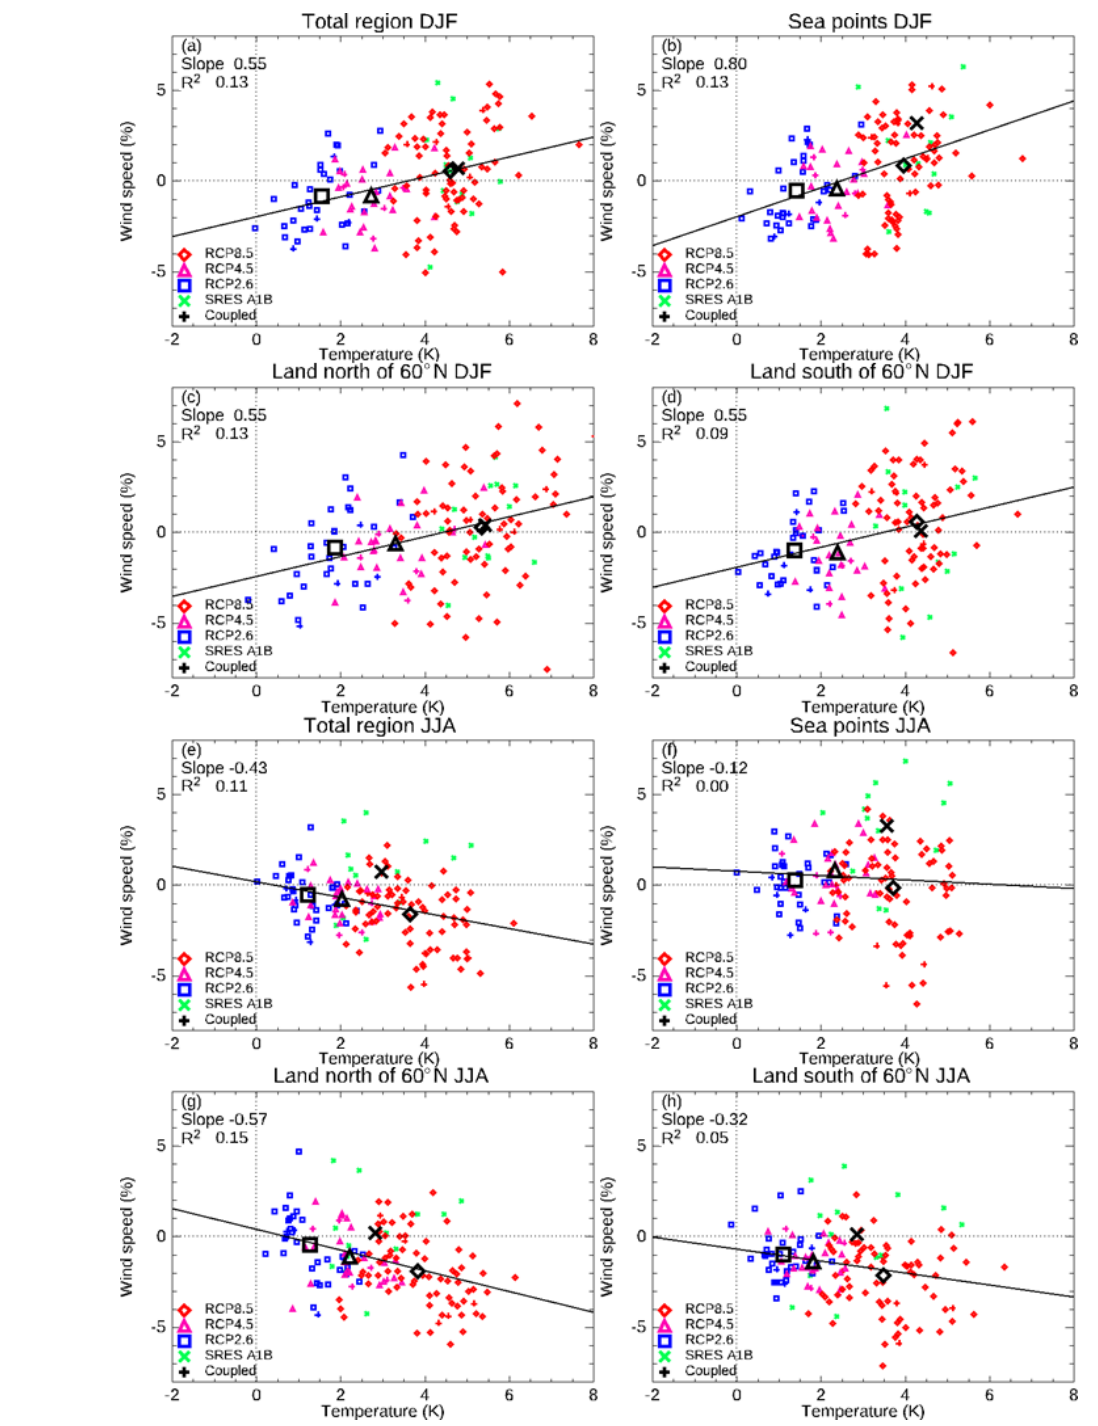
Figure 5. Relative change 1981–2010 to 2071–2100 of 10m wind speed against temperature change for individual models and all scenar- ios. Scenario means are indicated by larger black symbols. Blue squares: RCP2.6; pink triangles: RCP4.5; red diamonds: RCP8.5; green crosses: the ENSEMBLES simulations analysed in BACC II (2015). Plus signs in colours corresponding to the scenario: the RCA4-NEMO atmosphere–ocean coupled simulations. Calculation performed for subsets of the Baltic catchment: the entire catchment; sea points; land points north and south of 60 ◦ N, respectively. Panels (a–d) show winter; panels (e–h) show summer. The lines, with quoted slope and squared correlation coefficient, are best fits to all EURO-CORDEX and ENSEMBLES data but do not include coupled-model results.